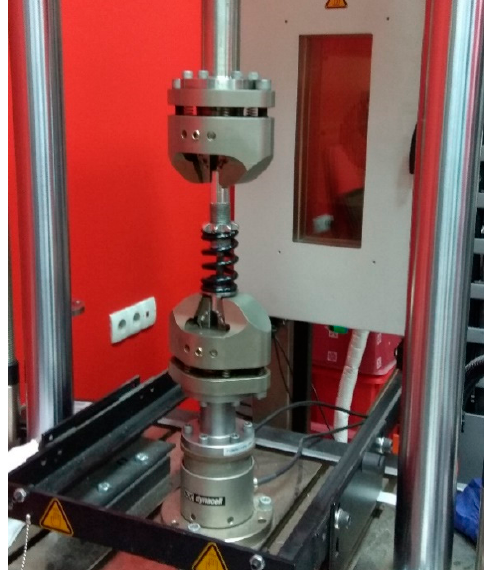
Figure 16. Photograph of shock absorber mounted in the testing machine.